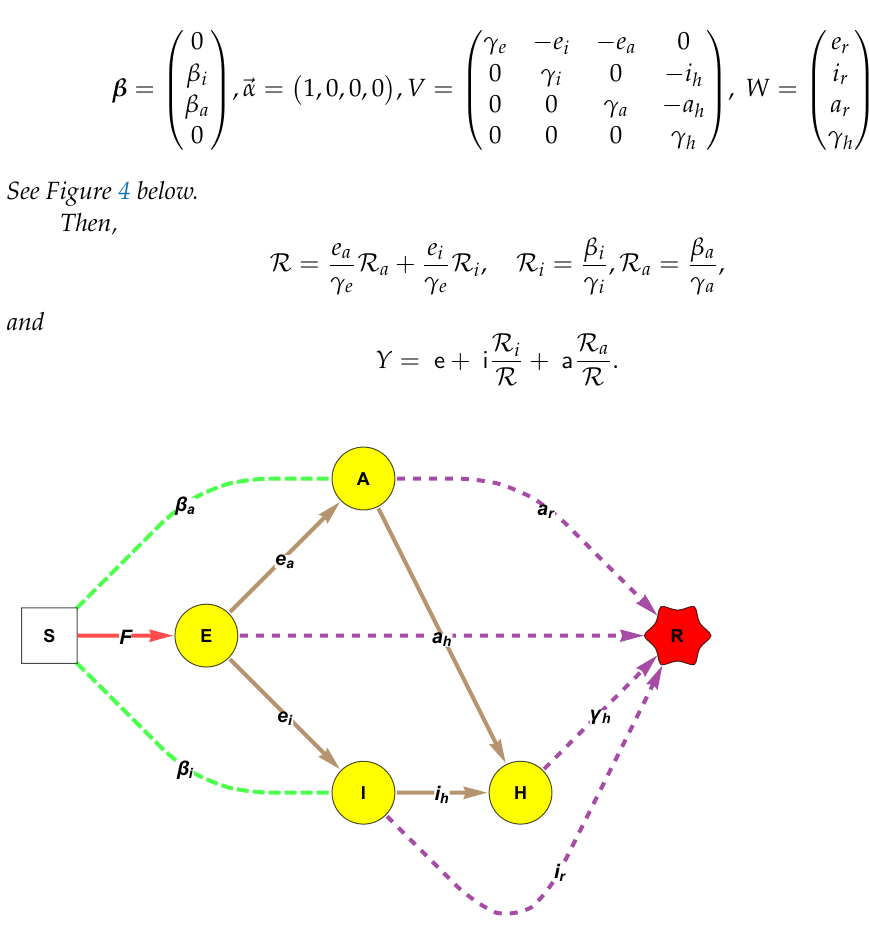
Figure 4. Flowchart of the SEIAHR model. The forces of infection are F si = β i i , F sa = β a a , F = F si + F sa